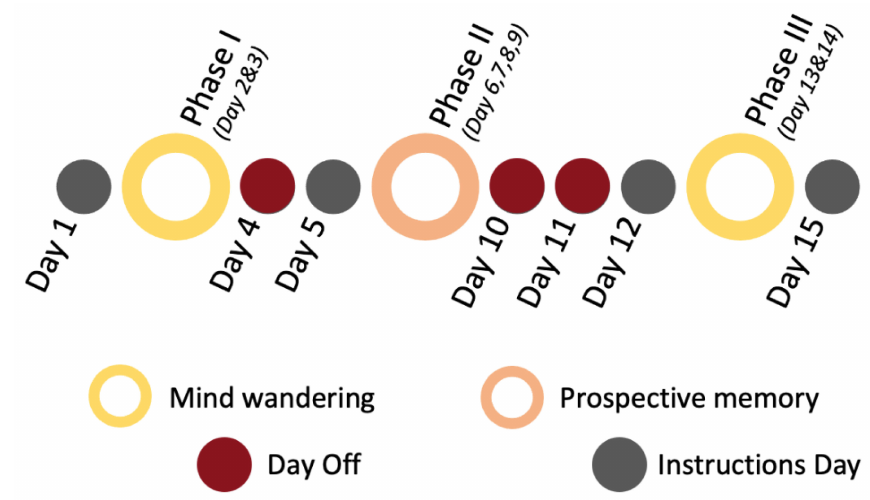
Figure 1. Overall conduct of the study process.